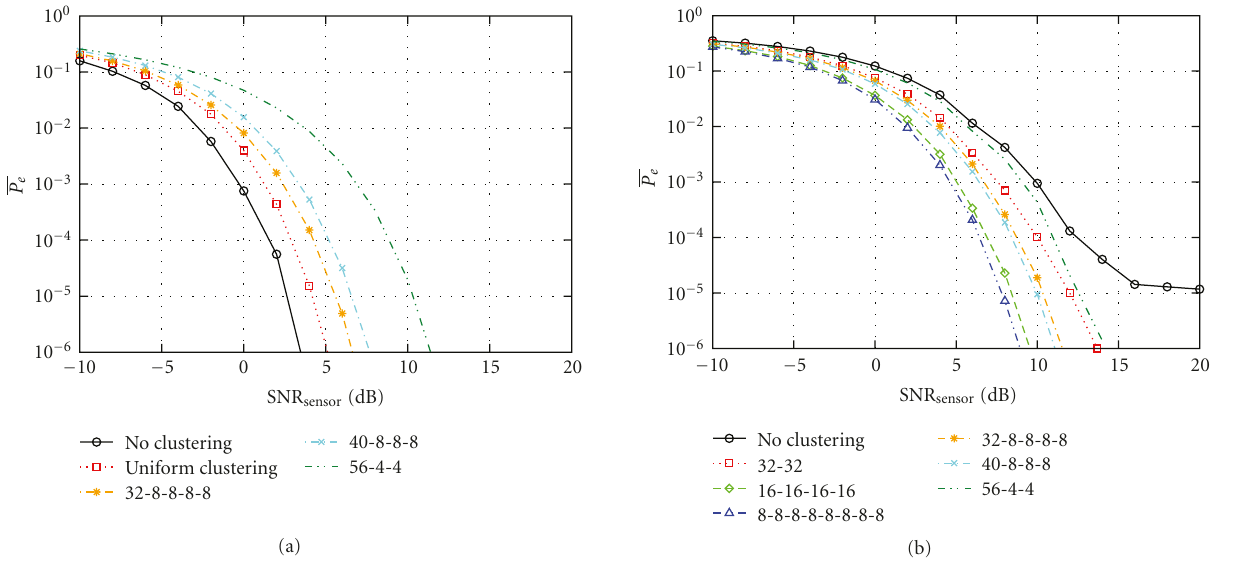
Figure 5: P e as a function of the sensor SNR, for di ff erent clustering configurations and ideal communication links. Case (a): ideal MAC; case (b): IEEE 802.15.4 MAC.